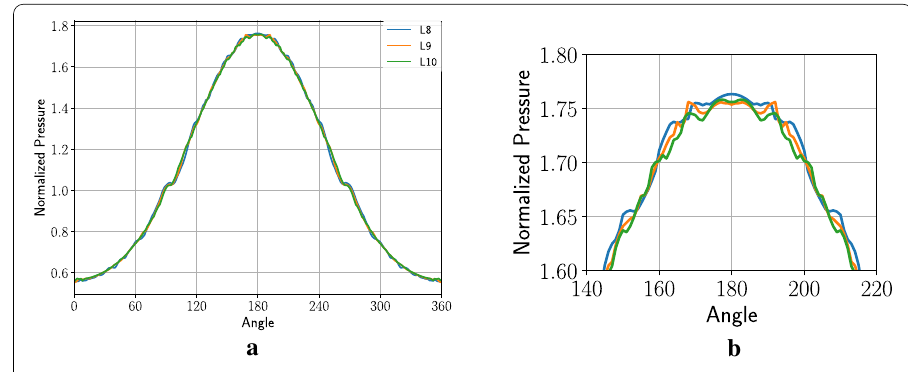
a b Fig. 12 Comparison: Moving cylinder for different mesh refinement levels (L) over the angle. a Surface pressure of the cylinder geometry over the angle for different mesh resolutions. b Zoom-in of the stagnation area (maxima)